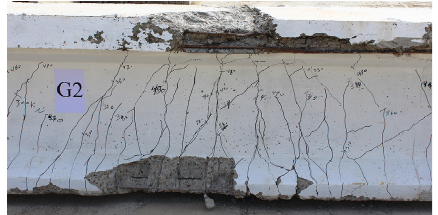
Figure 16: Concrete crushing at midspan of girder G2.